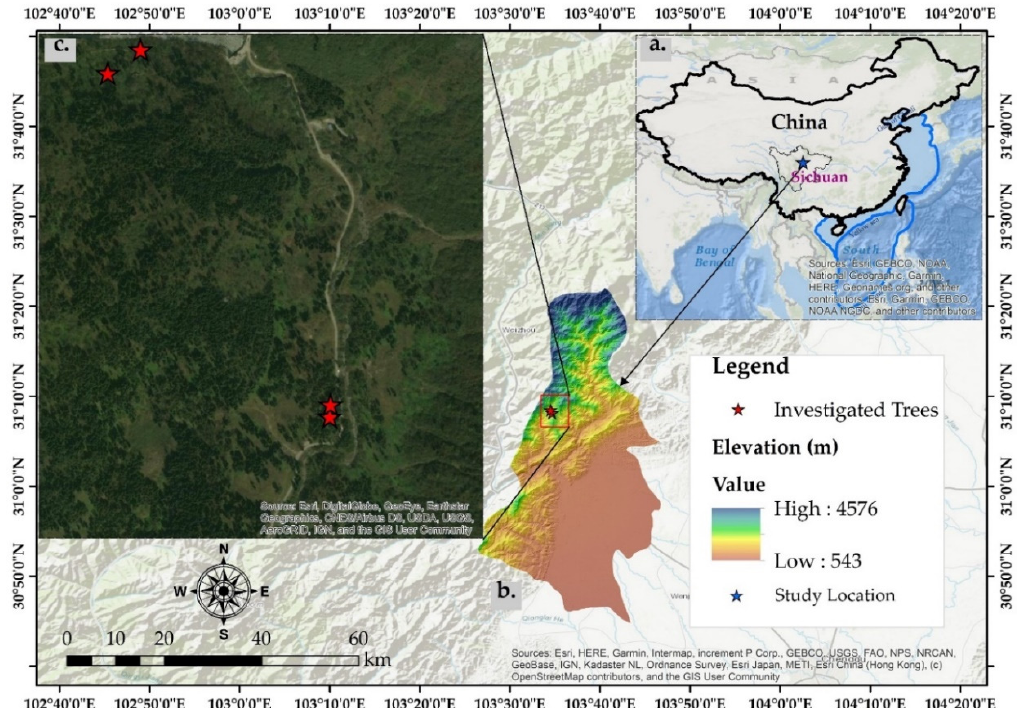
Figure 1. Location details of the study area.